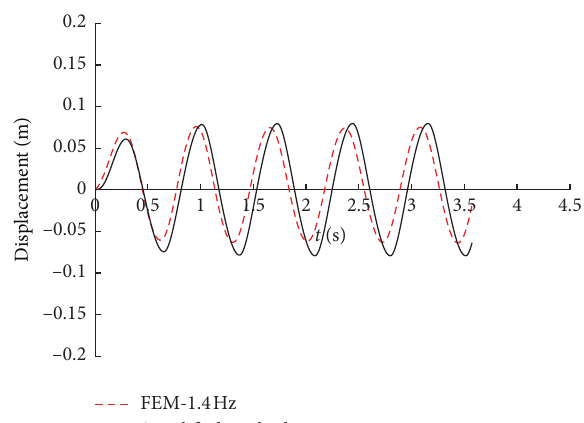
Figure 7: Time histories of lateral displacement atop the caisson before scouring.